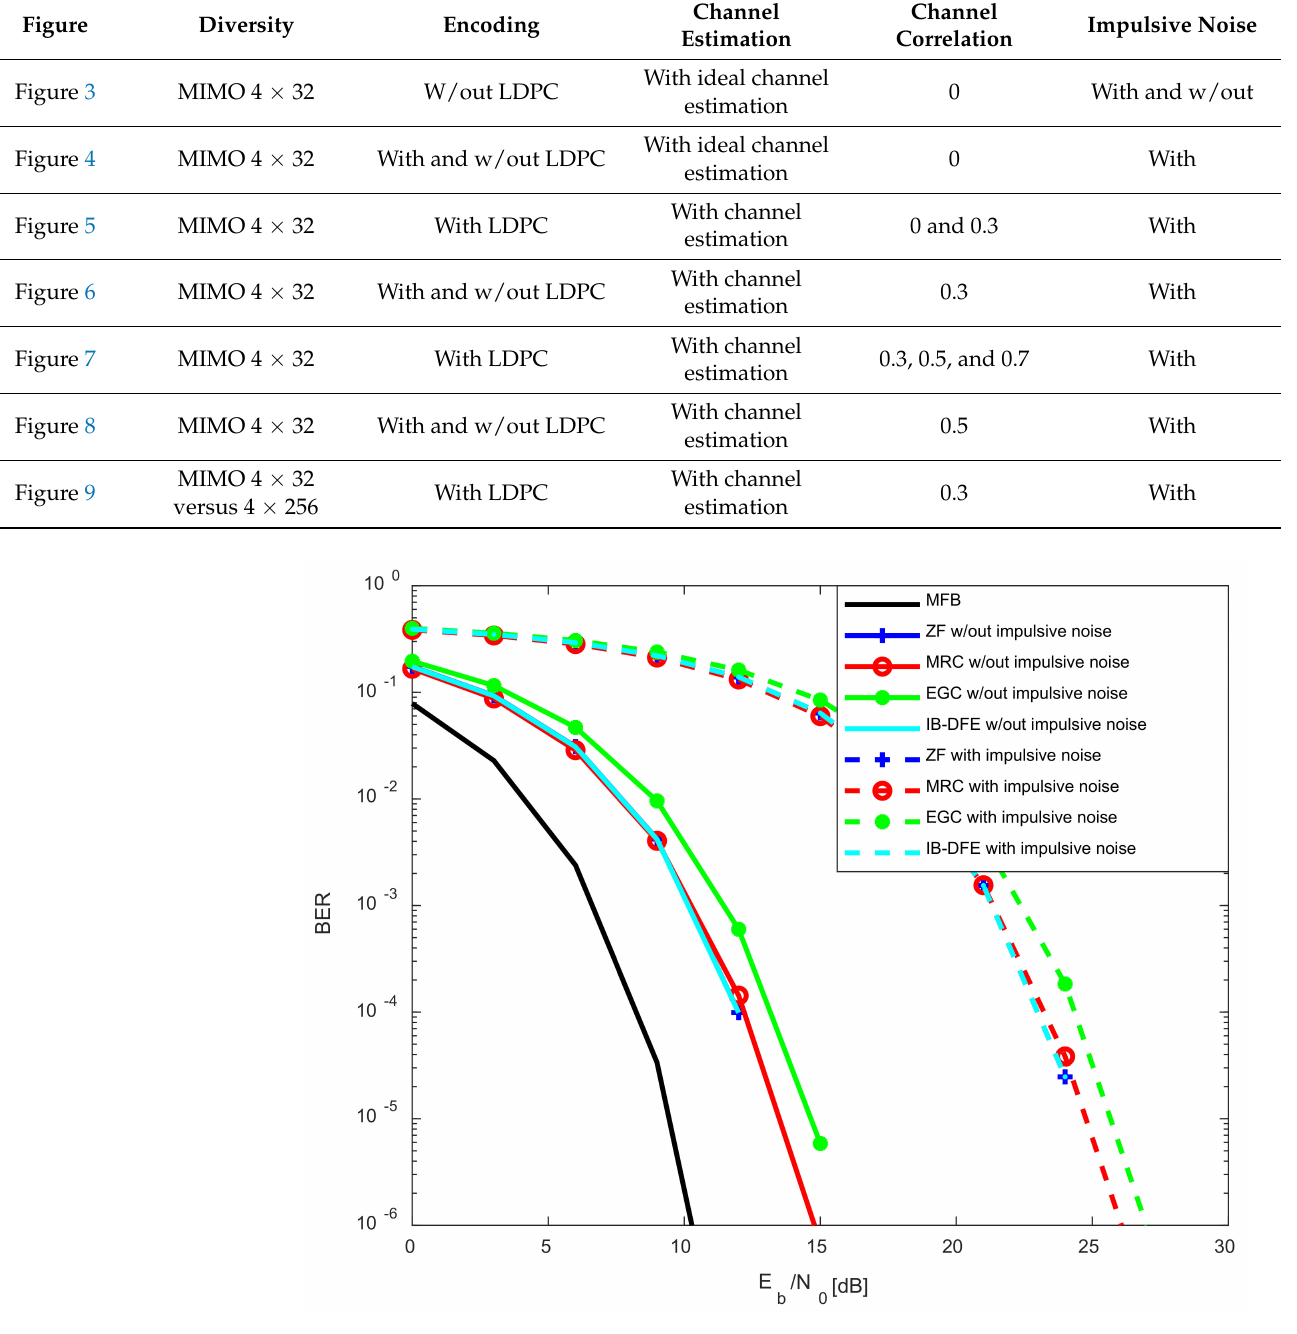
Table 1. List of baselines utilized in simulations.